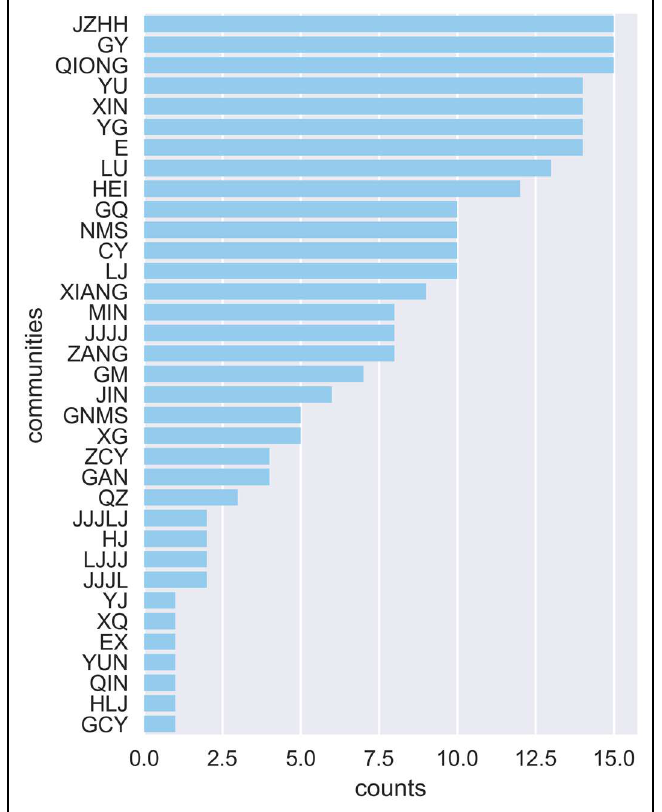
Figure 9. Number of times urban communities existed.